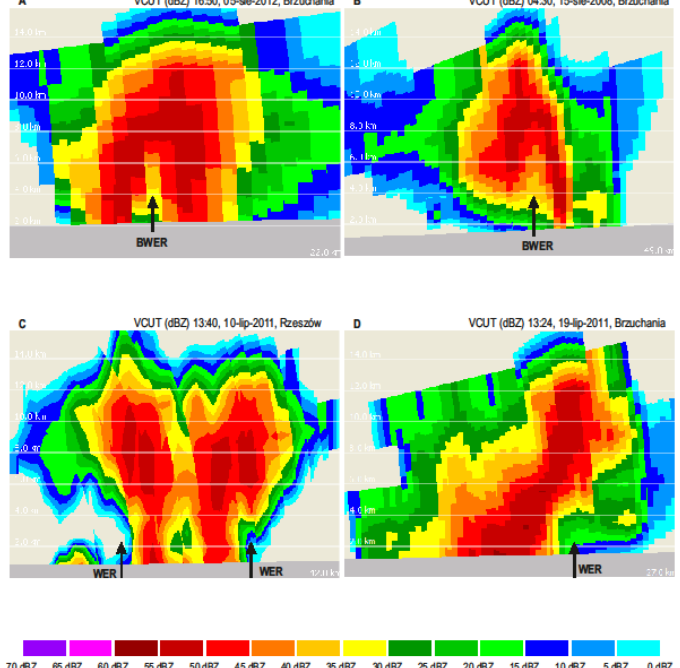
Fig. 5. Radar reflectivity cross-sections with the distinctive BWER (A and B) and WER (C and D) signatures. Time in UTC. Arrows denotes updraft location. A – RM (Right Moving) supercell storm with 6 cm hailstones in south eastern Poland, radar Brzuchania, August 5, 2012, B – the storm in Katowice in August 15, 2008 with hail 8,5 cm in diameter, radar Brzuchania, C – two supercell storms with hailstones up to 6 cm in diameter during the splitting process, radar Rzeszów, July 10, 2011 and D – RM supercell storm with 6 cm hailstones in south eastern Poland, radar Brzuchania, July 19, 2011, Source: